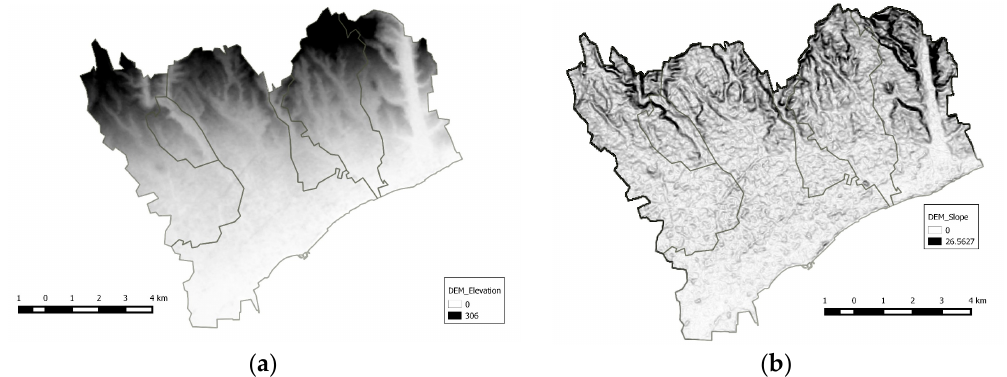
Figure 2. ( a ) The Digital Elevation Model (DEM) of the study area. The higher elevations are shown with darker pixels; ( b ) The ground slope of the study area extracted from the Digital Elevation Model. The flat areas are shown with light pixels.